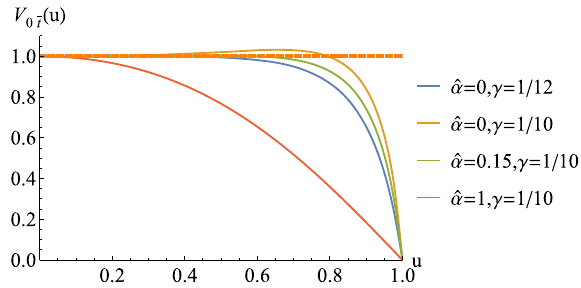
Fig. 14 The shape of the potentials V 0 ¯ t of the longitudinal mode A t with momentum dissipation ( ˆ α (cid:14)= 0) and without momentum dissi- pation ( ˆ α = 0) is shown for the γ beyond S 0 . For comparison, V 0 ¯ t with ˆ α = 0 and γ = 1 / 12 is also plotted. It clearly show that when the momentum dissipation is introduced, the constraint (A13) can also satisfied for wider region of γ beyond S 0 . (For interpretation of the ref- erences to color in this figure, the reader is referred to the web version of this paper)